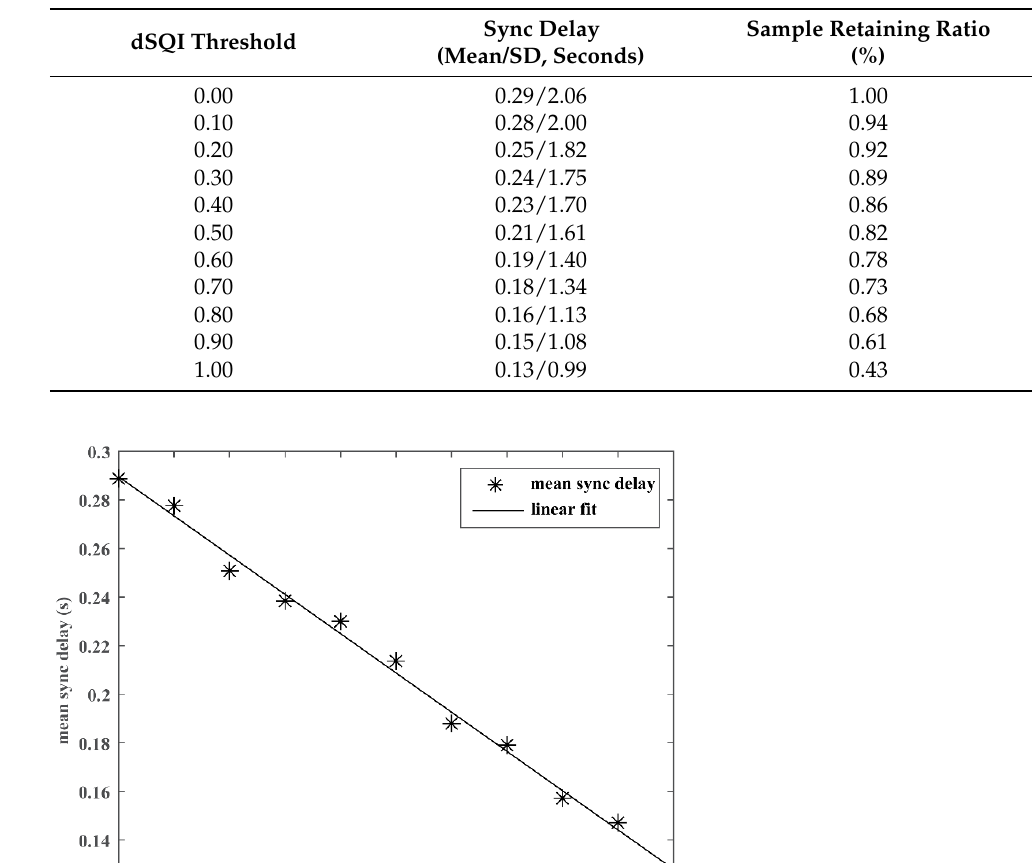
Table 1. Time-synchronization algorithm performance with varying dSQI thresholding.